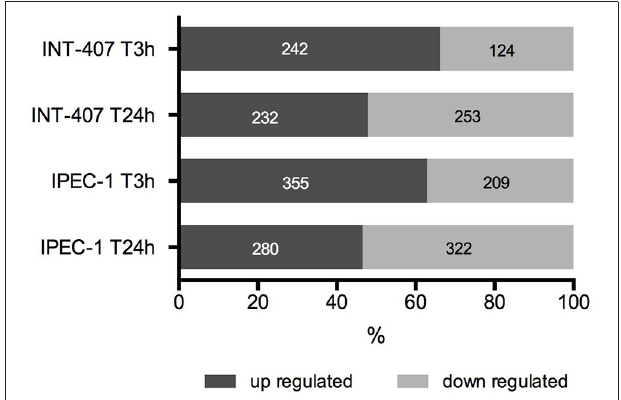
Frontiers in Cellular and Infection Microbiology |